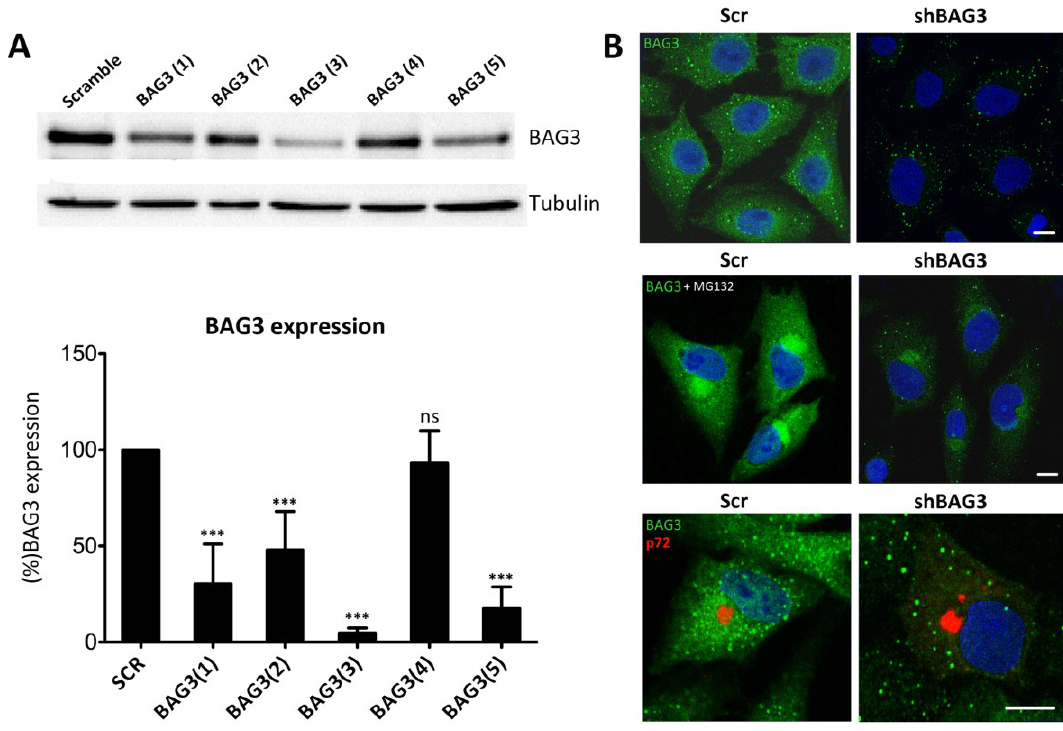
Figure 2. Analysis of Bag3 in VF formation ( A ) Levels of BAG3 silencing among five clones obtained from shBAG3 transduction in Vero cells. BAG3 clone number 3 (BAG3(3)) was the selected candidate for further experiments. Graphics in the lower panel show mean ± SD of WB quantification. ( B ) BAG3 expression in shBAG3(3) Vero cells and control (Scr) (upper panel); with proteasome inhibitor MG132 treatment (5 mM) for 16 h (middle panel) or infected with ASFV (moi = 1 pfu/cell). Capsid viral protein p72 (red) was used to detect VFs (lower panel). Asterisks denote statistically significant differences (*** = p < 0.001; ns = non significant). Bar = 10